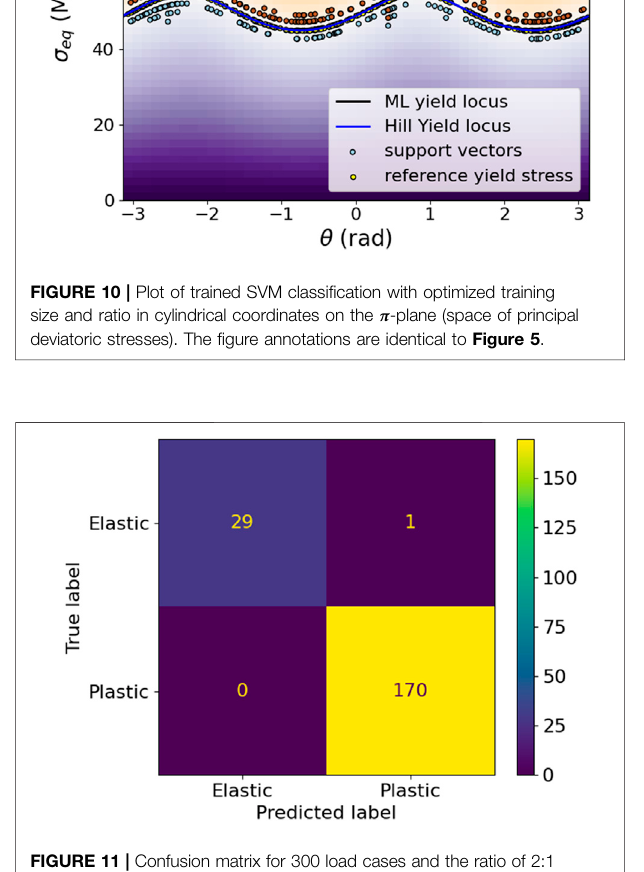
TABLE 3 | Summary of the metrics for 300 with the ratio of 2 between 3D and 6D load cases. Metrics Uniform Precision